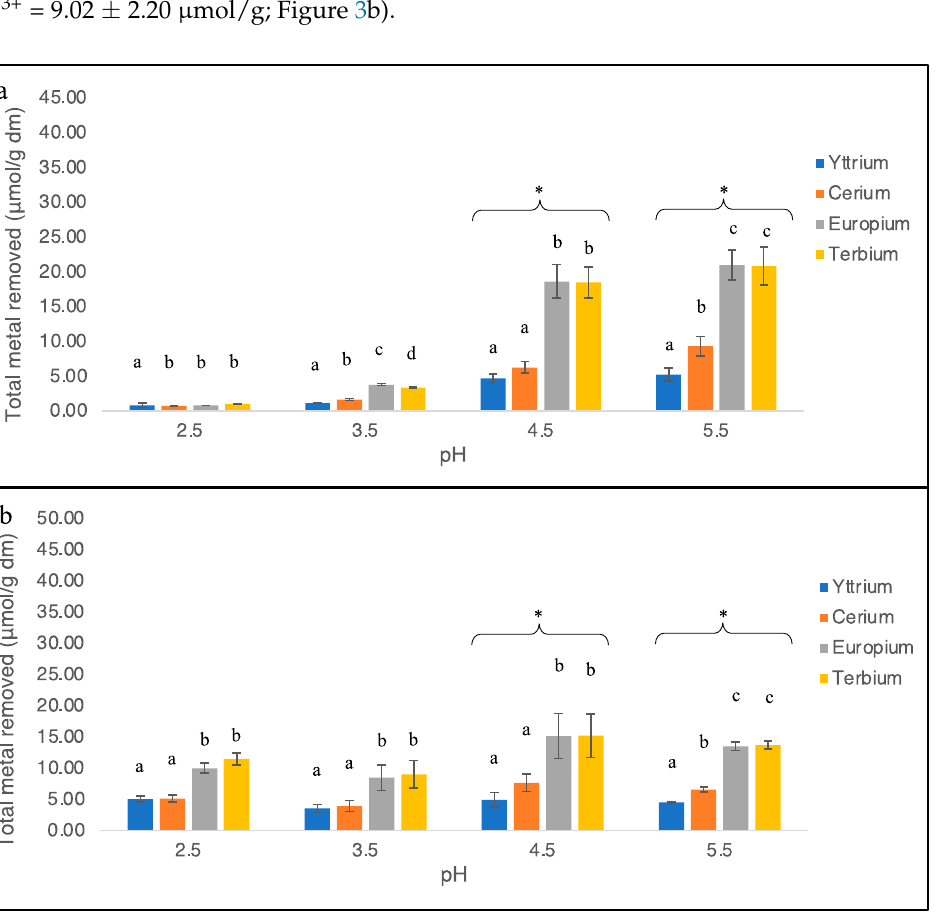
Figure 3. The metal removed from the quaternary-metal aqueous solutions by G. sulphuraria , strains SAG 107.79 ( a ) and ACUF 427 ( b ). Data were divided based on the pH of the solutions. Different letters in the same experiment indicate a significant difference, p < 0.05; Symbol (*) indicates a p < 0.05 significant difference compared to the pH 2.5.